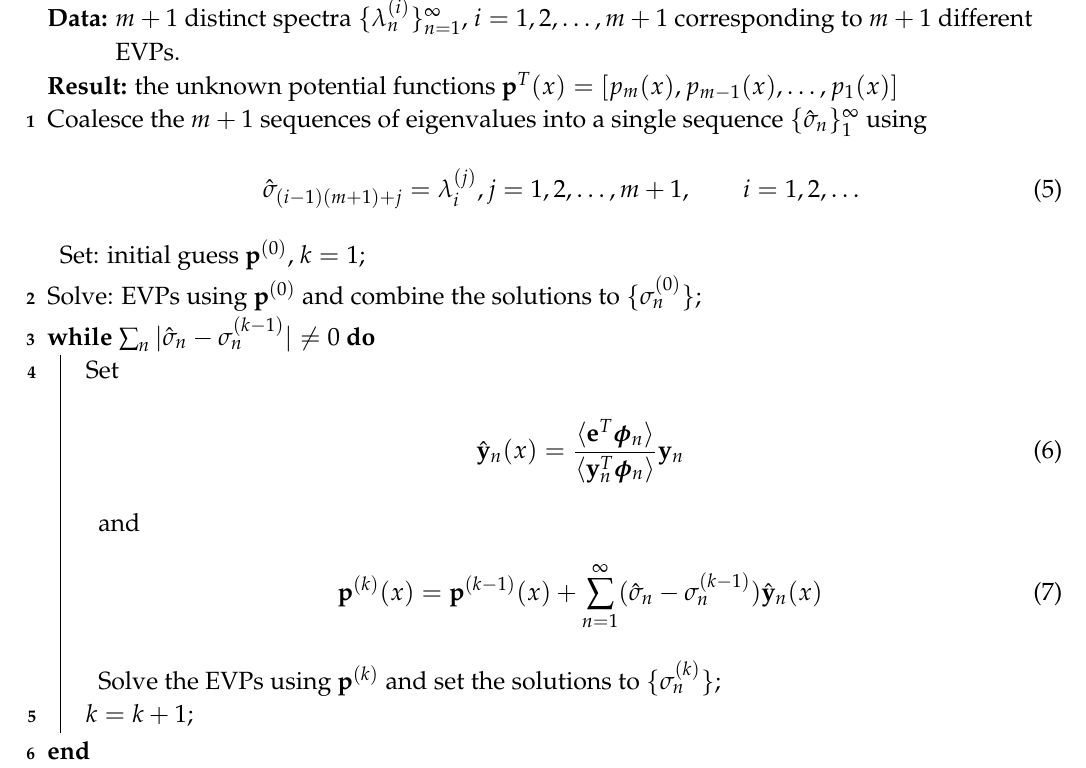
Algorithm 1: Solving inverse Sturm–Liouville problem